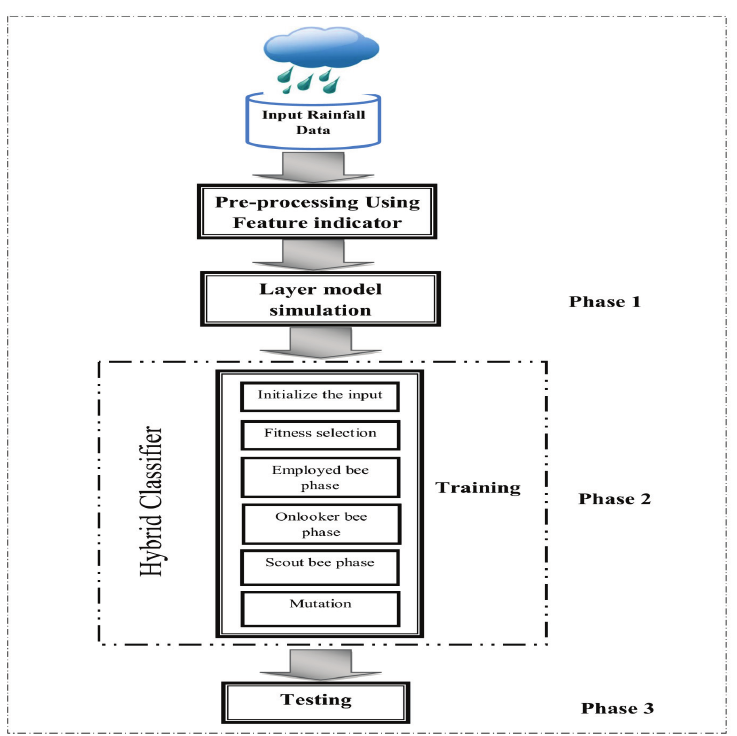
Fig.1. Overall block diagram of proposed rainfall prediction